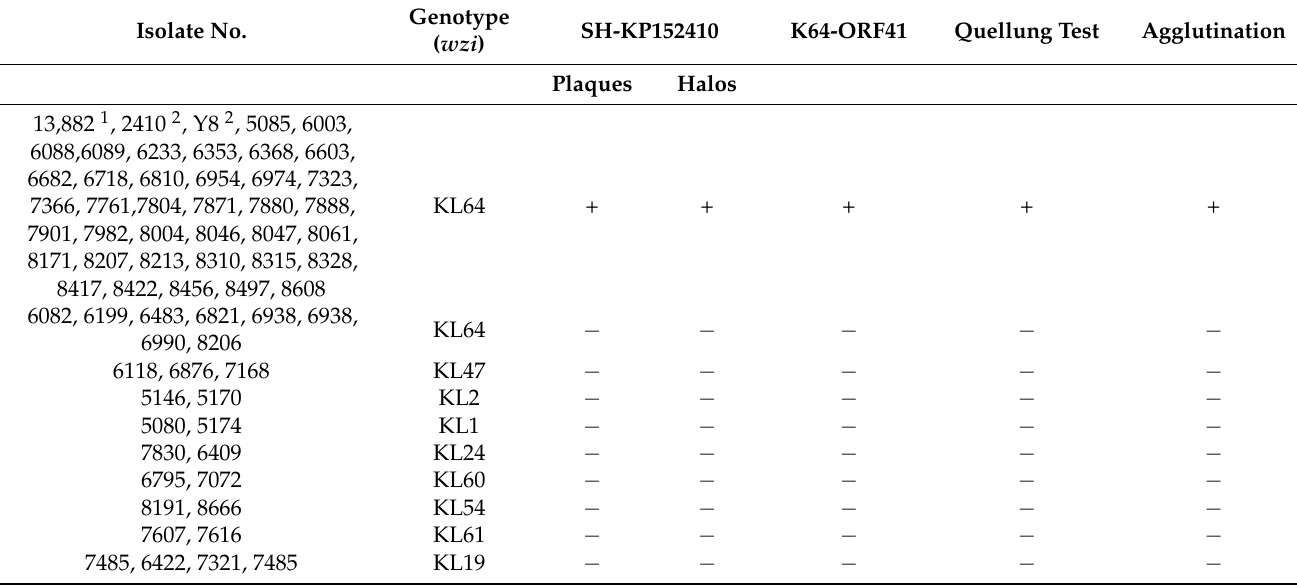
Table 1. The lytic spectrum of SH-KP152410 and K64-ORF41. Isolate